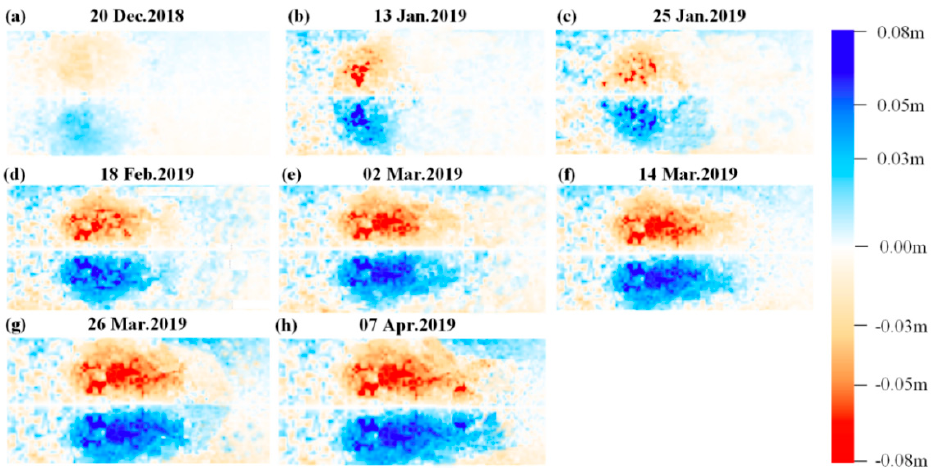
Figure 10. SGI-SF-derived time series of the horizontal displacements in the dip direction with reference to 26 November 2018. Positive and negative values denote the points moving toward the upward (vertical to the mining direction) and downward (vertical to the mining direction) directions, respectively. ( a – h ) are the horizontal displacements in the dip direction between 26 No-